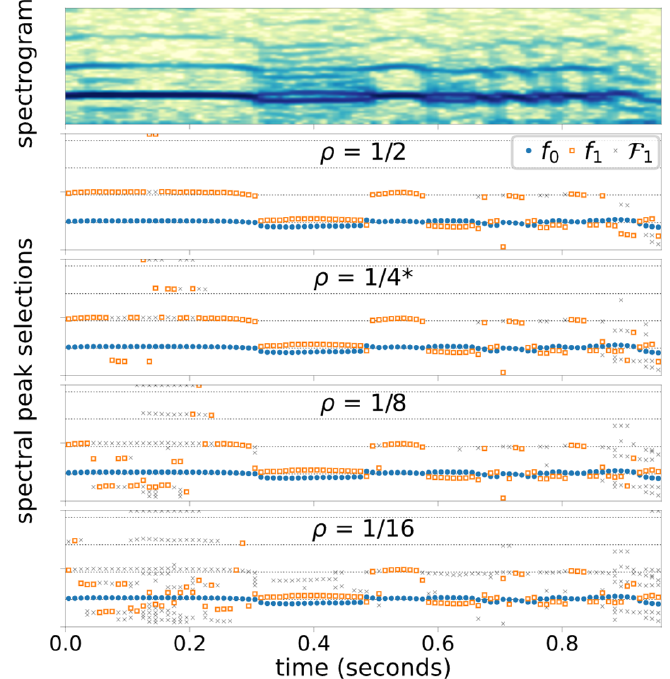
Figure 4. Case 3 Spectrogram and peak selection outcomes computed at four different thresholds, 𝜌. Horizontal grid lines approximate the harmonic frequencies. * indicates the base configuration.